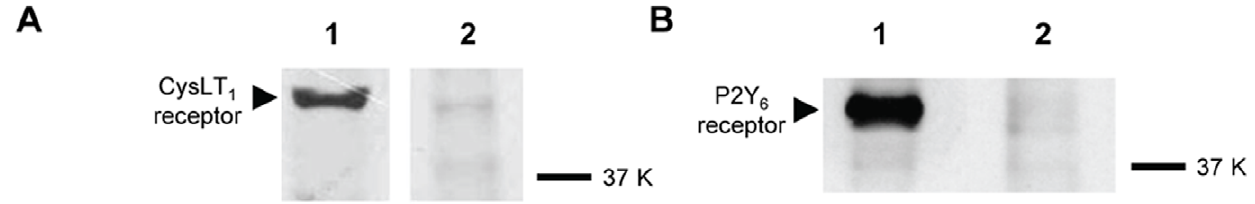
Figure 1. Western blotting analysis showing the protein expression of CysLT 1 and P2Y 6 receptors in 16HBE14o- cells. The expression of CysLT 1 (44 kDa) and P2Y 6 (41 kDa) receptors was demonstrated (lane 1), and their positions on the blot closely matched their calculated molecular masses of 39 kDa and 36 kDa, respectively. Detection of these protein bands appeared specific, as they were mostly blocked by prior reabsorption of the antibodies with their respective control antigen for 2 h at 4 u C (lane 2).